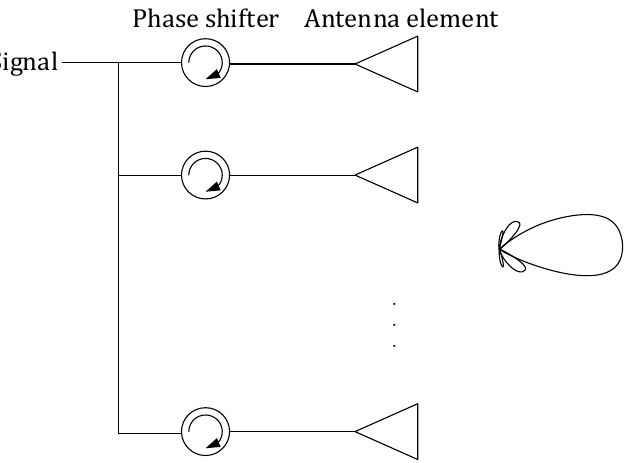
Figure 8. Schematic diagram of the traditional beamforming.